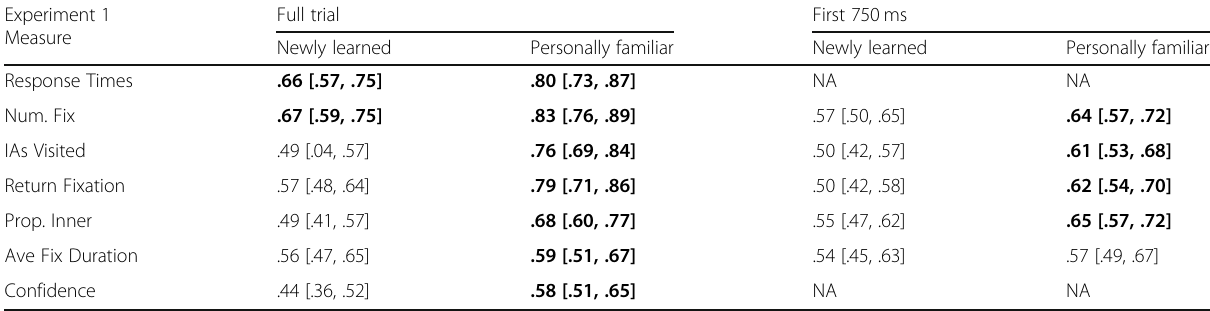
Table 1 Areas under the curve [95% CIs] calculated for all markers of recognition in Experiment 1 for the full trial period and first 750 ms of the trial. Numbers in bold indicate AUCs above chance (i.e. the lower bound limit CI exceeds .50) Experiment 1